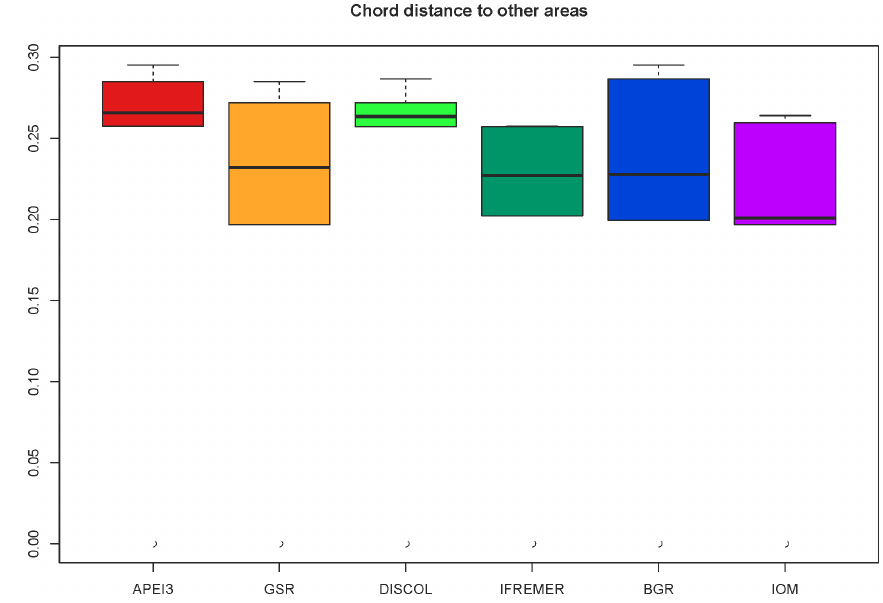
Figure 11. Box and whiskers plot showing the median and range of the chord distance of every area to other